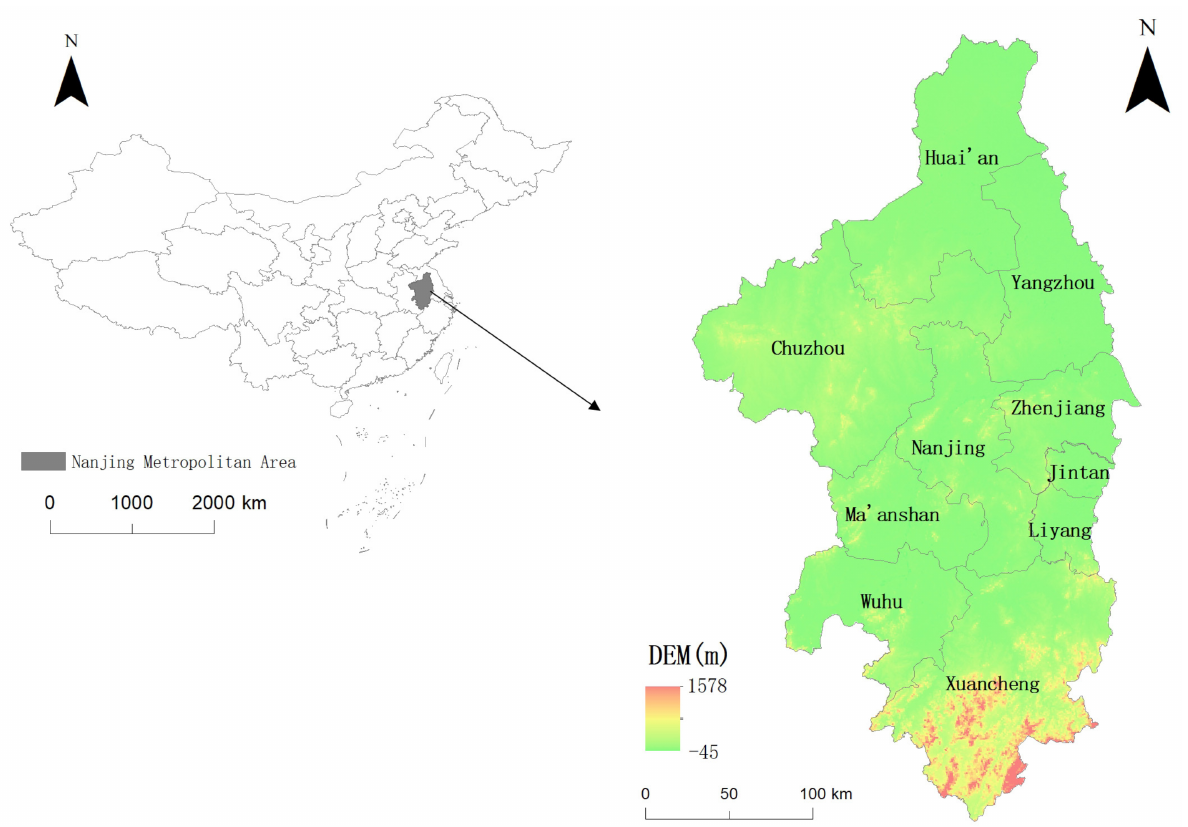
Figure 1. Location of the Nanjing metropolitan